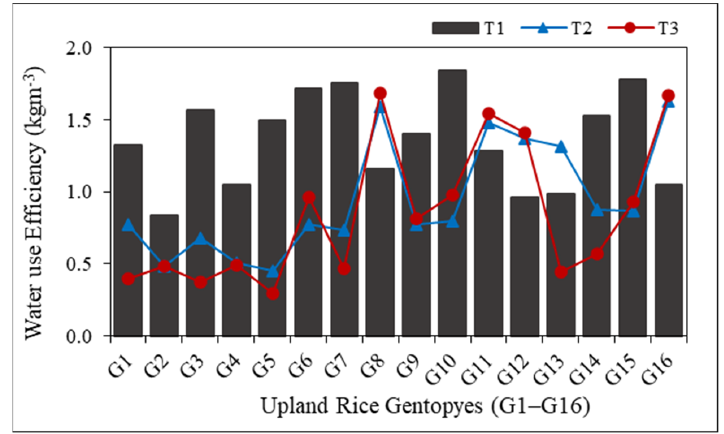
Figure 11. Simulated water use efficiency for sixteen upland rice genotypes under T1: control (100% FC), T2: moderate stress (70% FC), and T3: severe stress (50% FC) treatments in yield assessment experiment.